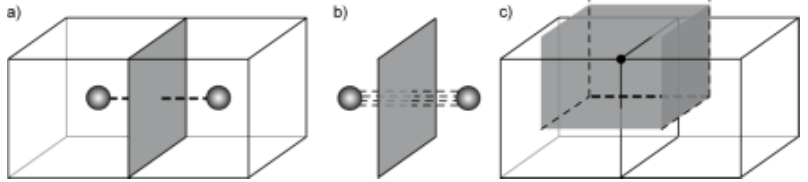
Figure 3. Connections between cells: (a) adjacent cells, that share a face (grey), are connected by a dual edge (dashed line); (b) a dual edge is represented as a bundle of edges penetrating a face; (c) each one of the edges from the bundle belongs to a cell surrounding one of the face vertices.